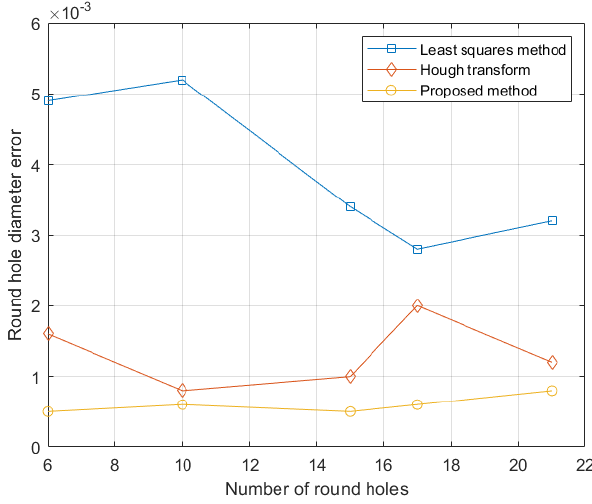
Figure 3. The error curve of circular hole diameter for different number of punched circles in Figure 2.